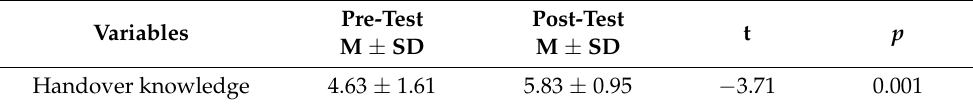
Table 1. Comparison of handover knowledge before and after the education program ( N = 30).